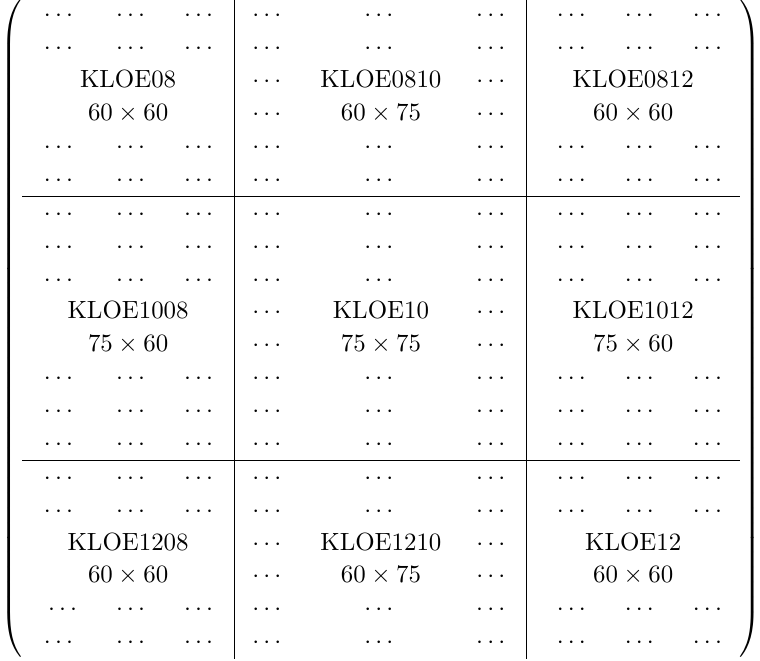
Figure 2. The KLOE (cid:25) + (cid:25) (cid:0) (cid:13) ( (cid:13) ) combination matrix structure for both the statistical and sys- tematic covariance